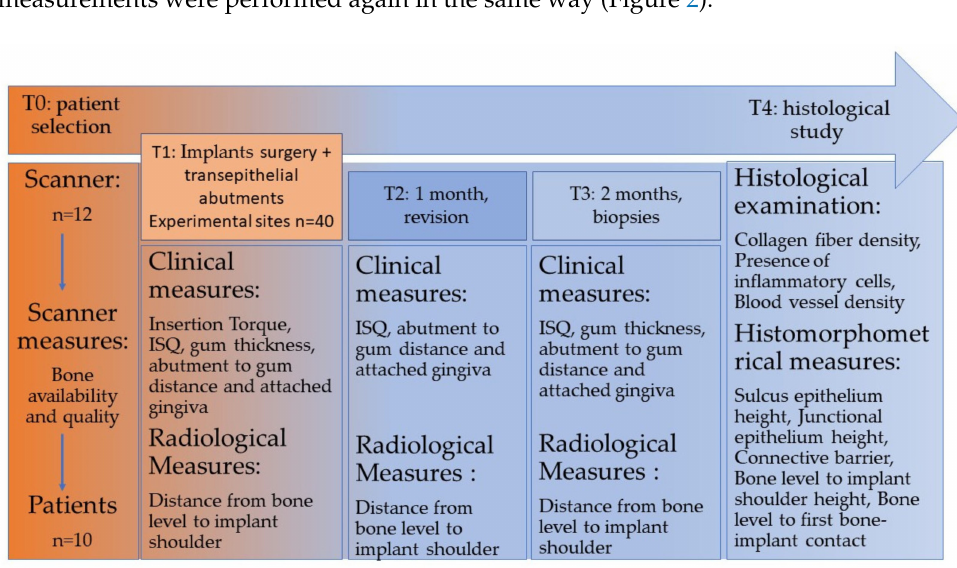
Figure 2. Timeline of stages